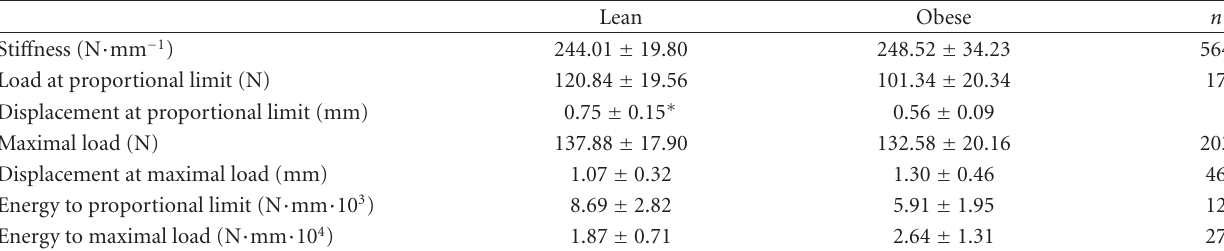
Table 5: L 6 structural properties.